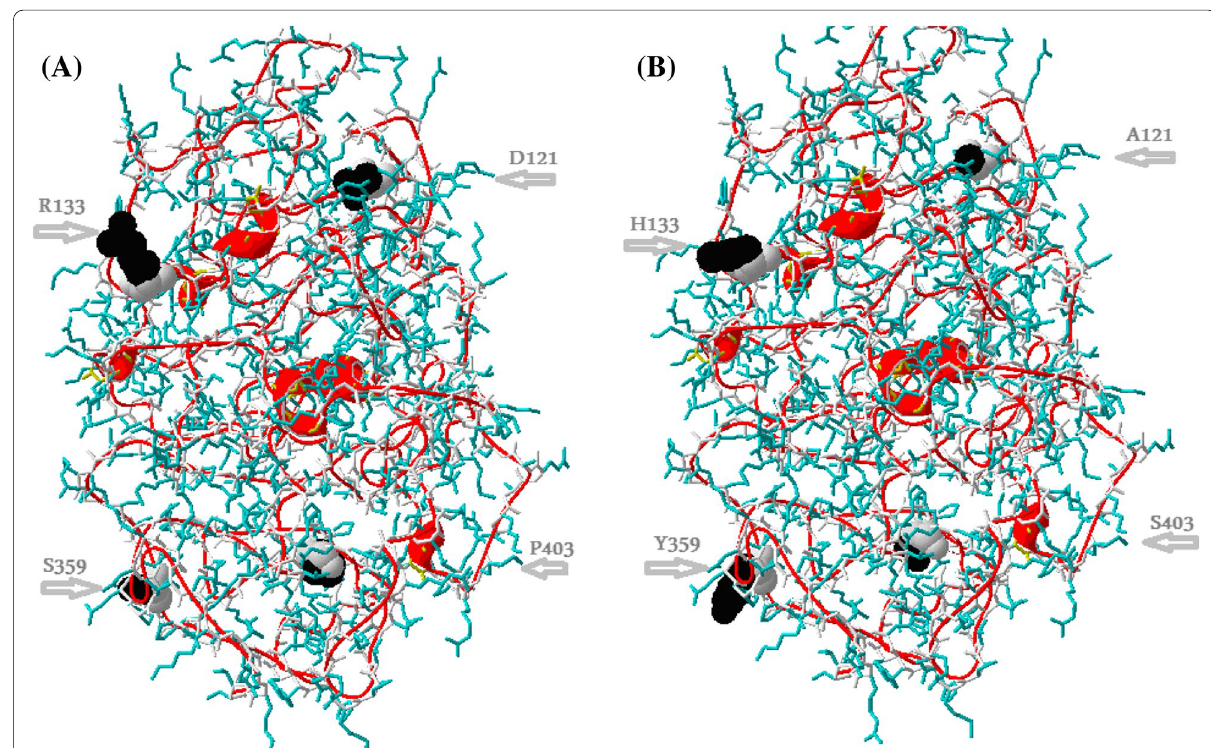
Fig. 1 The whole MeCP2 protein model using Phyre 2 server with localized annotated detected variants. A Wild MeCP2 and B mutant MeCP2. The wild and mutant amino acids are represented by volumed ribbon configuration, and the gray arrows indicate the outer position of the detected variants